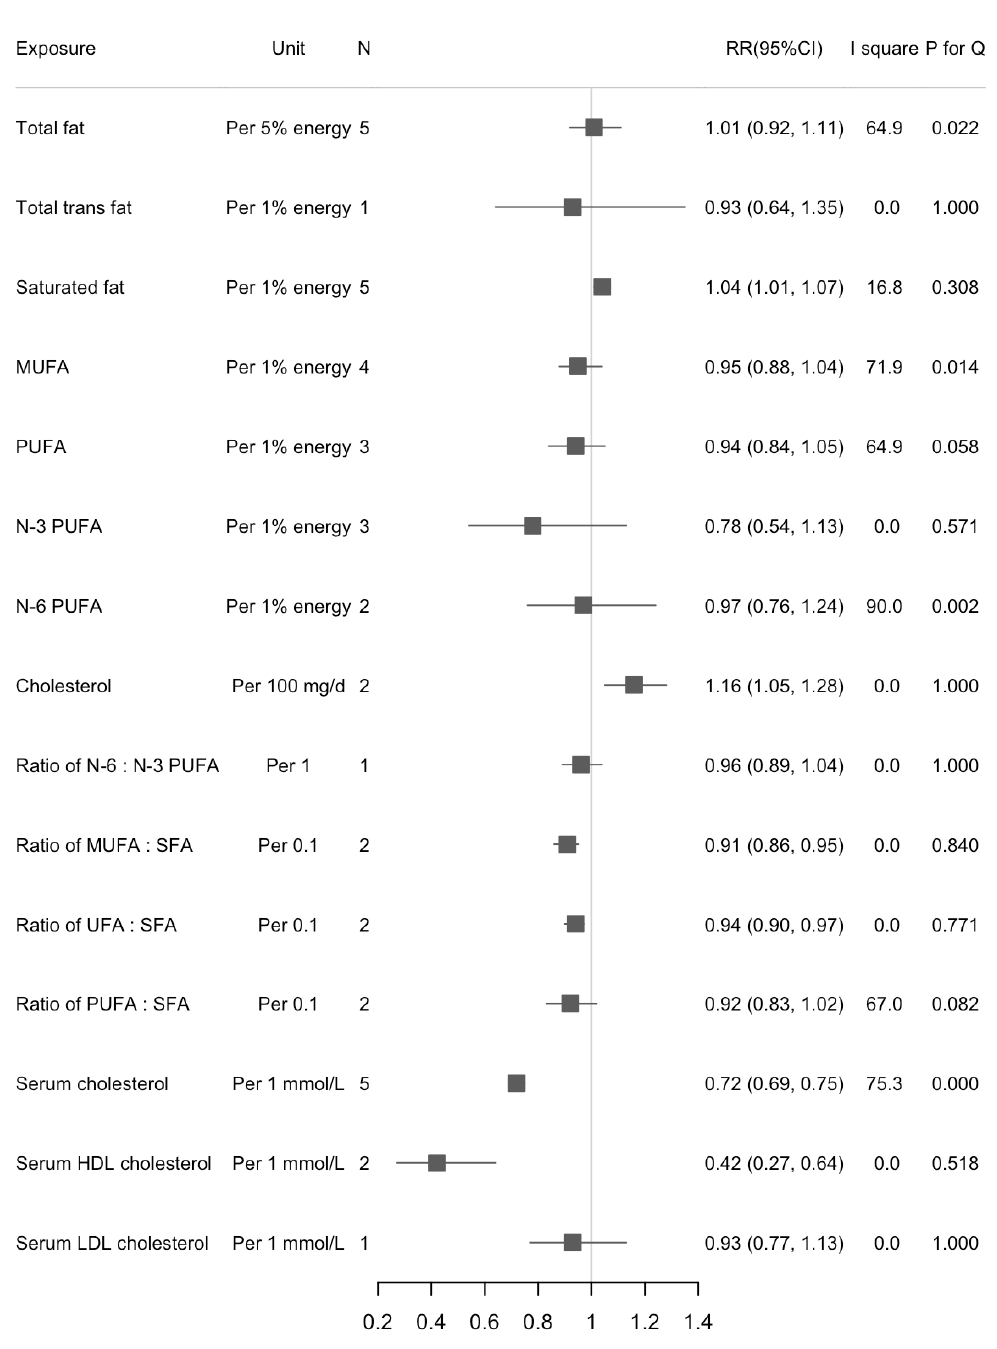
Figure 3. Summary of associations between dietary fats and serum cholesterol and liver cancer (dose-response analysis).